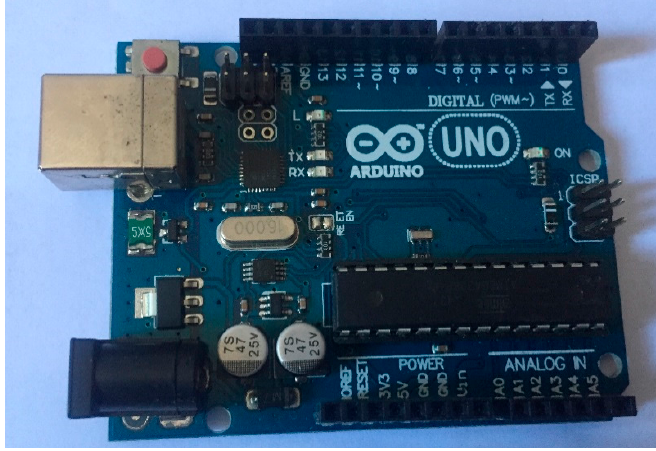
Figure 4. Arduino card. Figure 4. Arduino